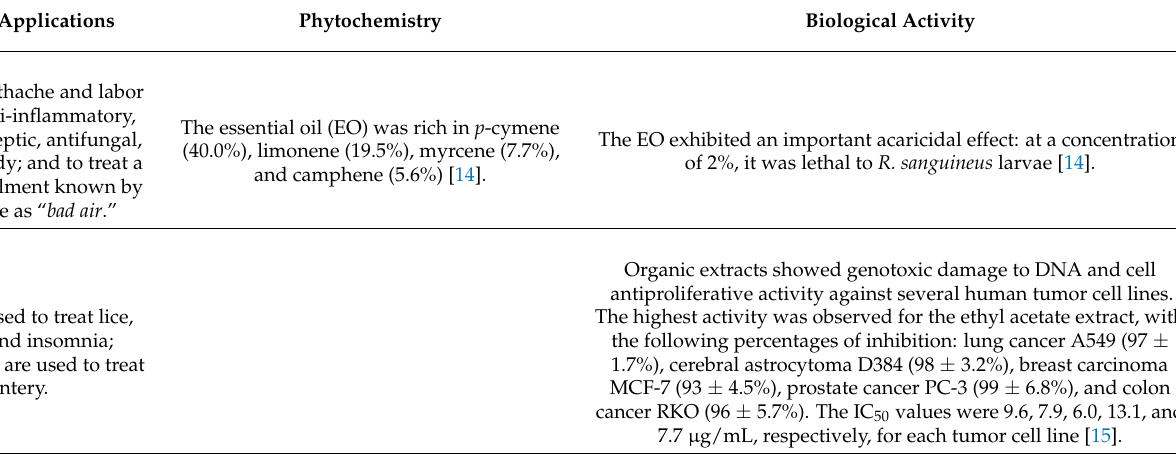
Table 1. Literature on Ecuadorian medicinal plants in the period 2016–July